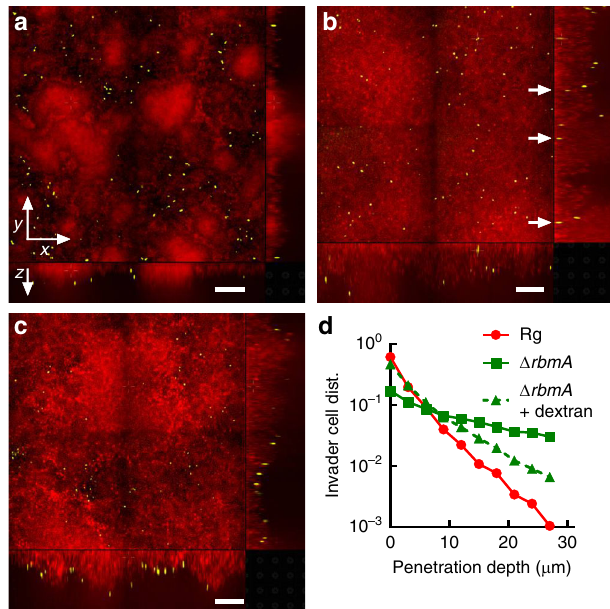
Fig. 6 Osmotic-pressure-driven swelling modulates V. cholerae submerged bio fi lm susceptibility to invasion. a – c Representative cross-sectional confocal images of resident bio fi lms carrying mKate2 ( red ) invaded for 10 min by Δ vpsL strain carrying mKO ( yellow ). The resident bio fi lm strain is Rg in a and Δ rbmA in b and c . Invasions were performed in M9 medium without dextran in a and b and with 15% dextran in c . Shown are the xy cross-sectional views in the upper left panels and the two orthogonal views in the bottom and right panels. White arrows in b are guides to show invader cells that have successfully penetrated the resident Δ rbmA submerged bio fi lm. Scale bars : 30 μ m. d Distributions (denoted dist.) of invader cells as a function of penetration depth into the resident Rg ( red circles ), Δ rbmA ( green squares ), and Δ rbmA submerged bio fi lms in the presence of 15% dextran ( green triangles ). Distributions are normalized by the total number of invader cells in each